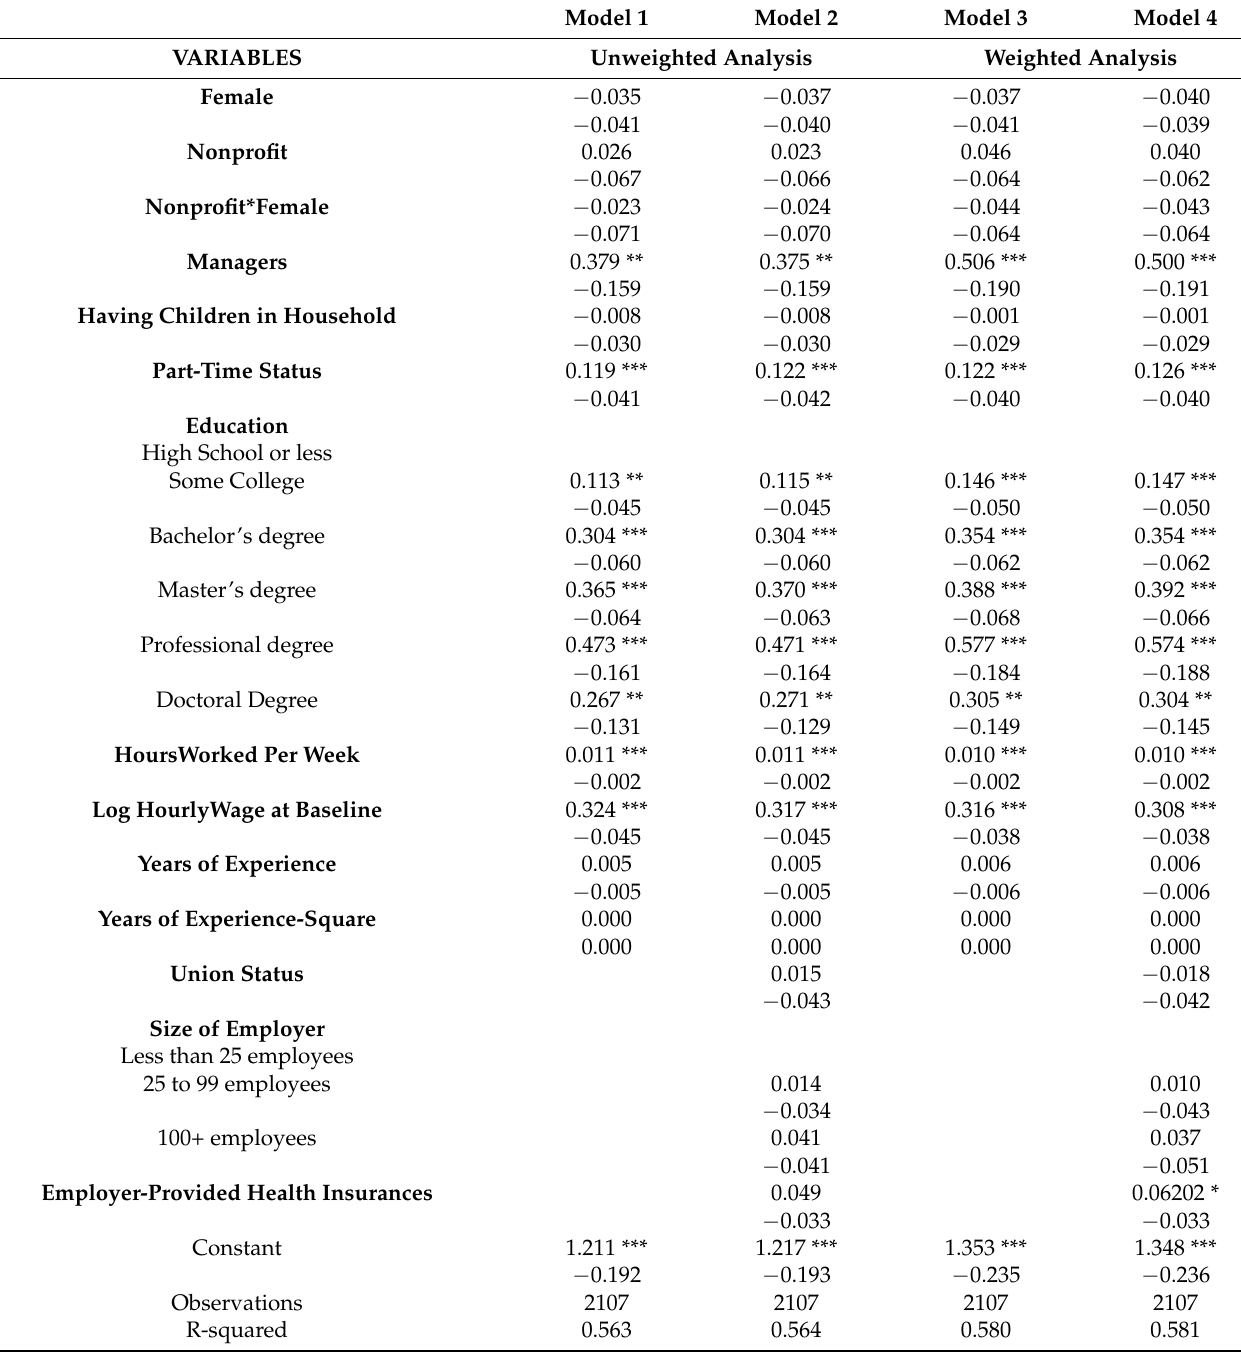
Table 5. Regression results of the weighted and unweighted